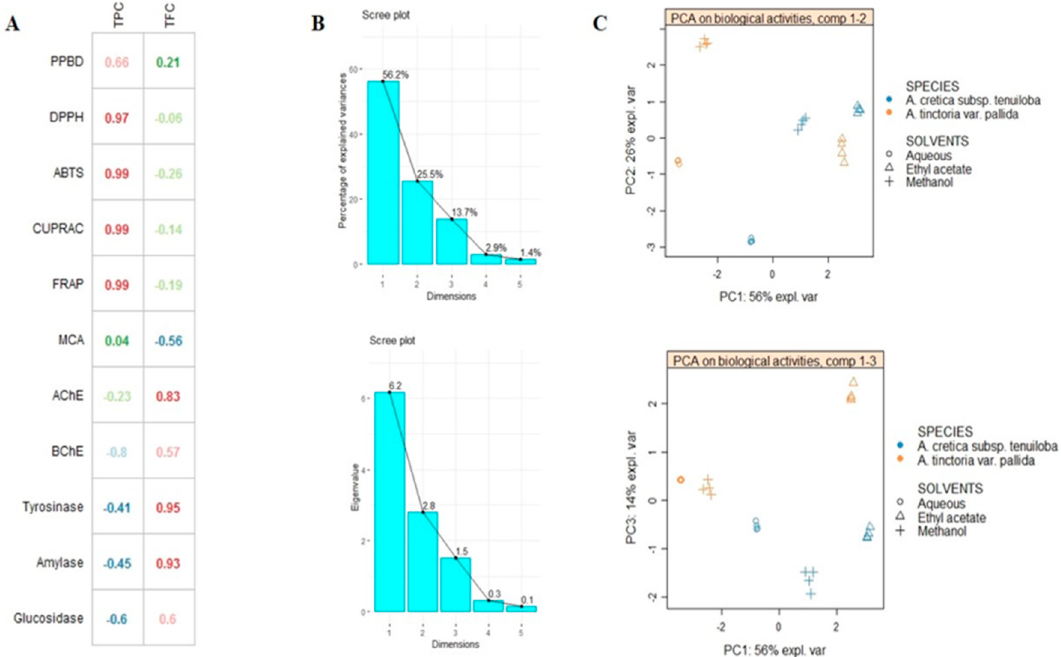
Figure 1. ( A ): Relationship between total phenol content (TPC), total flavonoid content (TFC) and biological activities. ( B , C ): results of preliminary multivariate analysis with PCA ( B : Percentage of explained variance and Eigen value per component, C : PCA sample plot on PC1 vs. PC2 and PC1 vs. PC3 respectively).